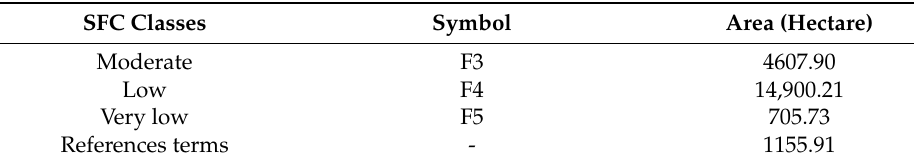
Table 8. Areas of SFC classes in the study area.